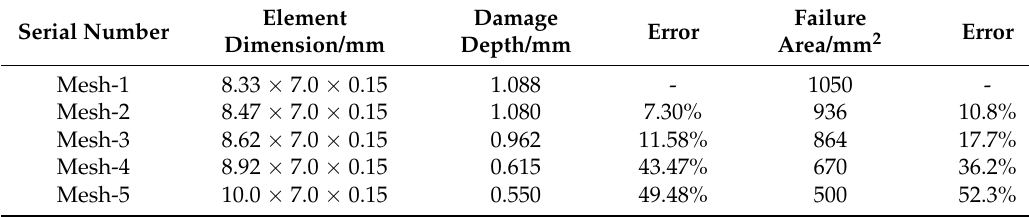
Table 8. Comparison of calculation results for different element